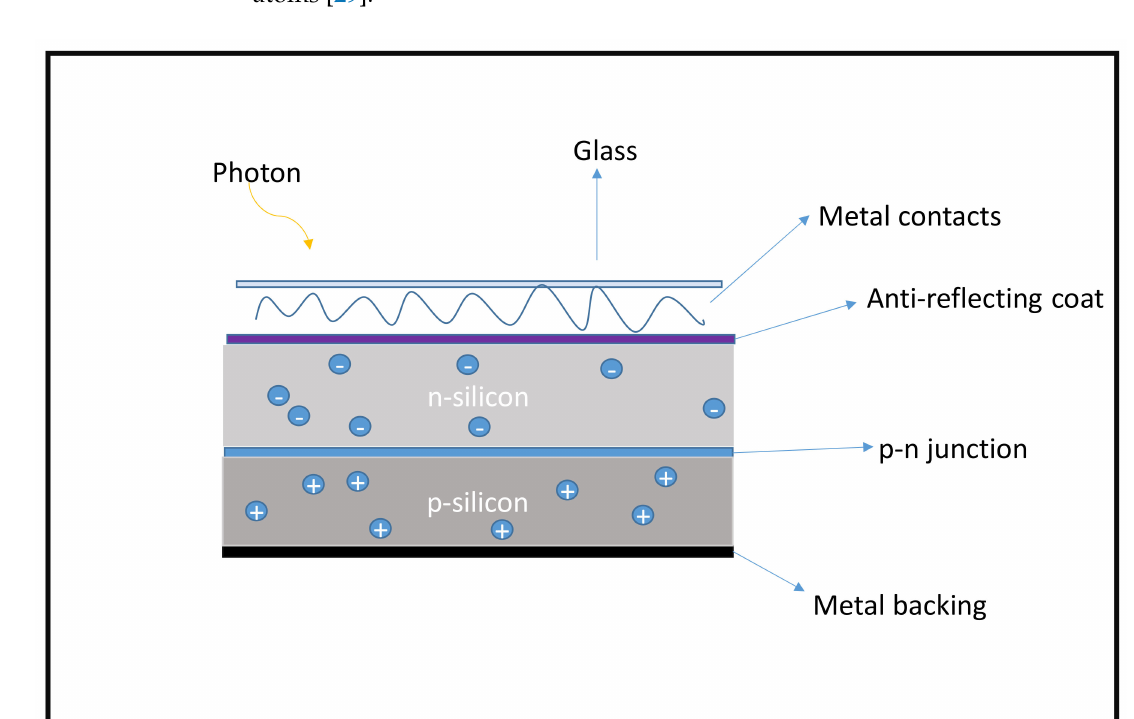
Figure 2. Schematic structure of typical a silicon solar cell